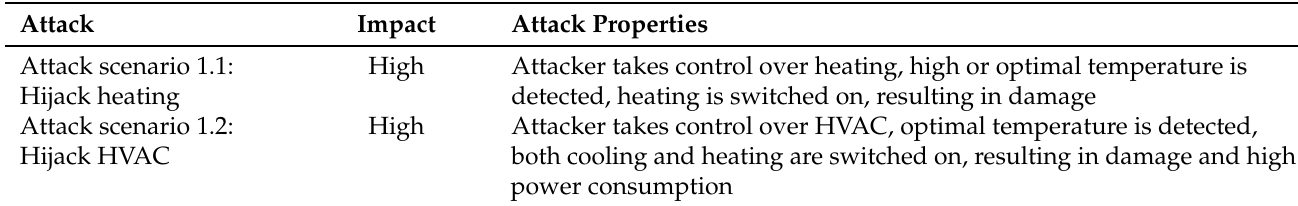
Table 9. Modeled attacks, their impact and properties for UC1.